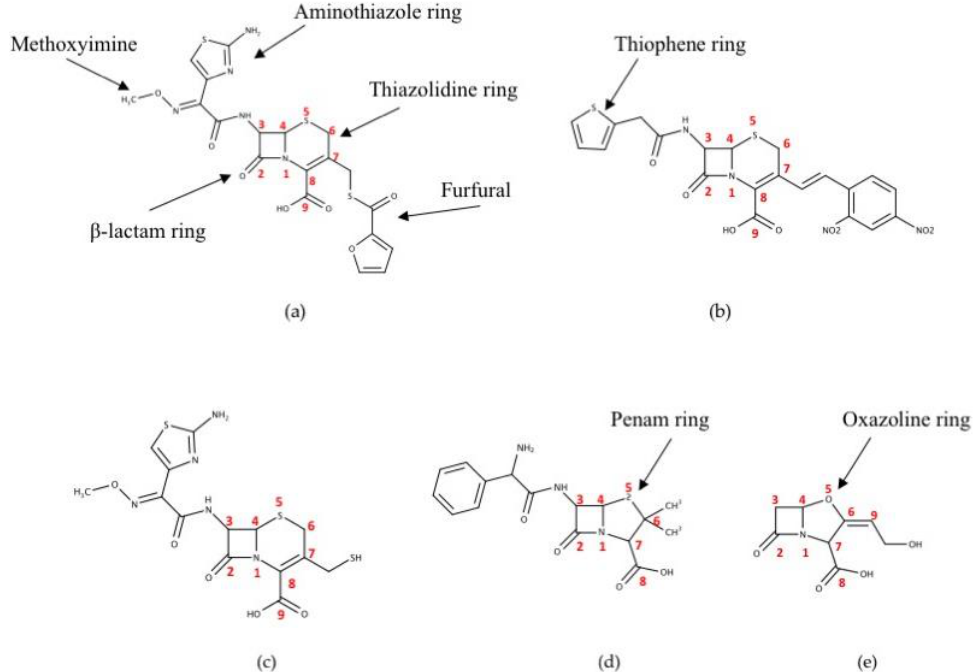
Figure 1. Chemical structures of five β -lactam compounds. ( a ) Ceftiofur; ( b ) Nitrocefin; ( c ) Desfuroylceftiofur (DFC); ( d ) Ampicillin; ( e ) Clavulanic acid. Thiazolidine, β -lactam, aminothiazole,